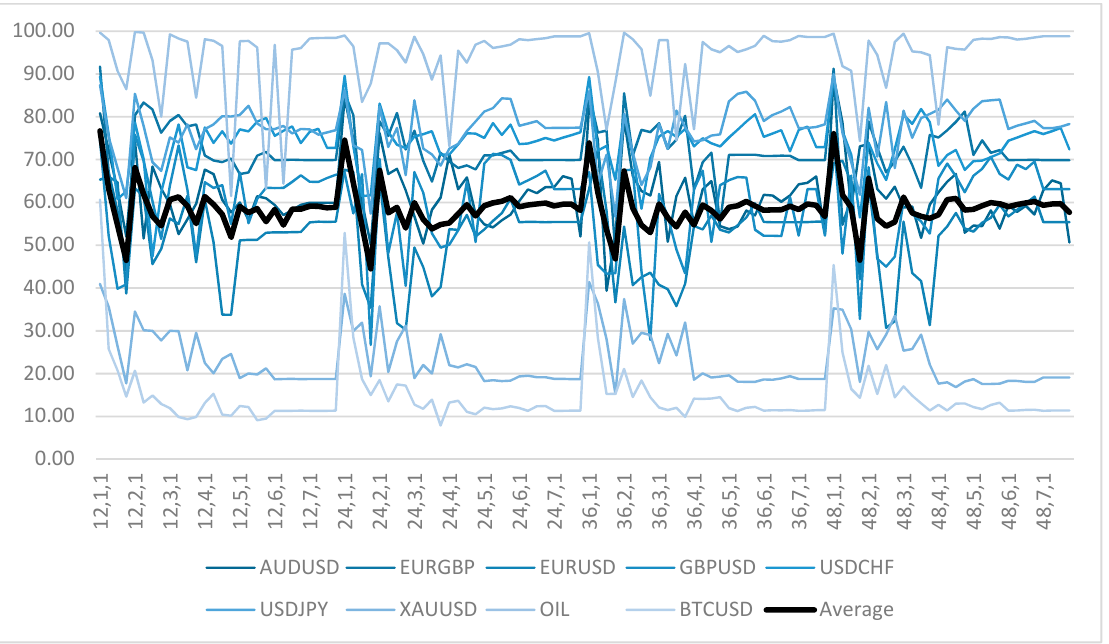
Figure 17. Drawdown, as percentage of equity, of experiment (h) for various combinations of N, x , y .